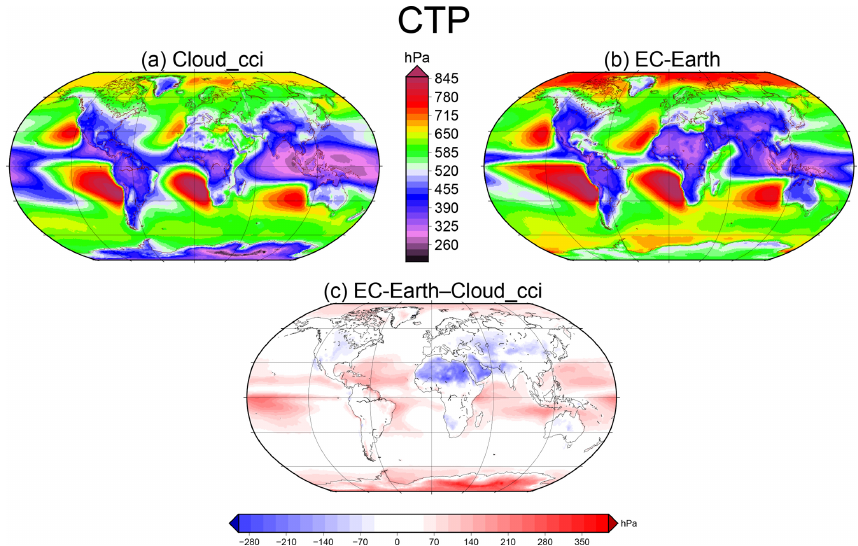
Figure 8. The CTP from the Cloud_cci CDR (a) , simulated CTP based on EC-Earth (b) and the difference between the two (c) . The data cover the time period